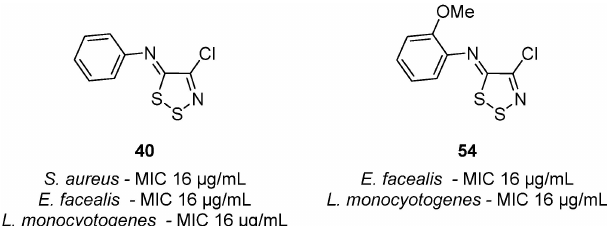
Figure 7. Report on a small panel of 1,2,3-dithiazoles highlighted some nascent antibacterial activity on the dithiazole